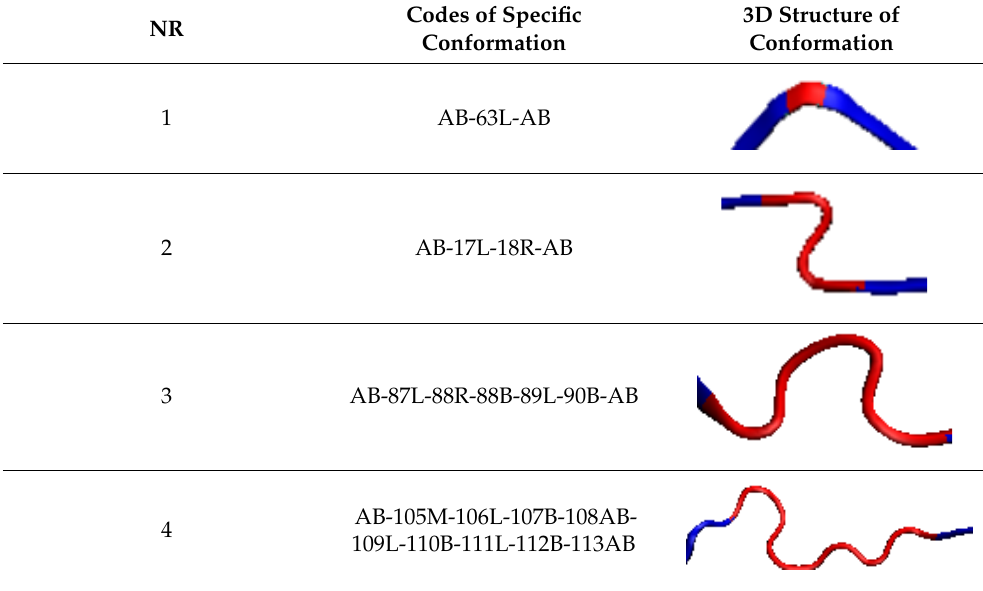
Table 1. The proposed classification of specific structural forms leading to maintenance of a planar structure of chains present in amyloid fibrils. β -structure conformations are marked in blue-marine, with those different from β -structure in red. First column (left) lists the identification as shown in Figure 4A. Symbol designations: AB — amyloid form of β structure (Phi and Psi angles fulfill the relation Psi = − Phi), R/L — Phi and Psi angles from right/left-handed α -helix area of Ramachandran plot, B —β structure, M — Phi, Psi angles from the area between α -helical and β structural forms. The numbers accompanying the codes — positions of residues in the fragments under consideration. NR Codes of Specific Conformation